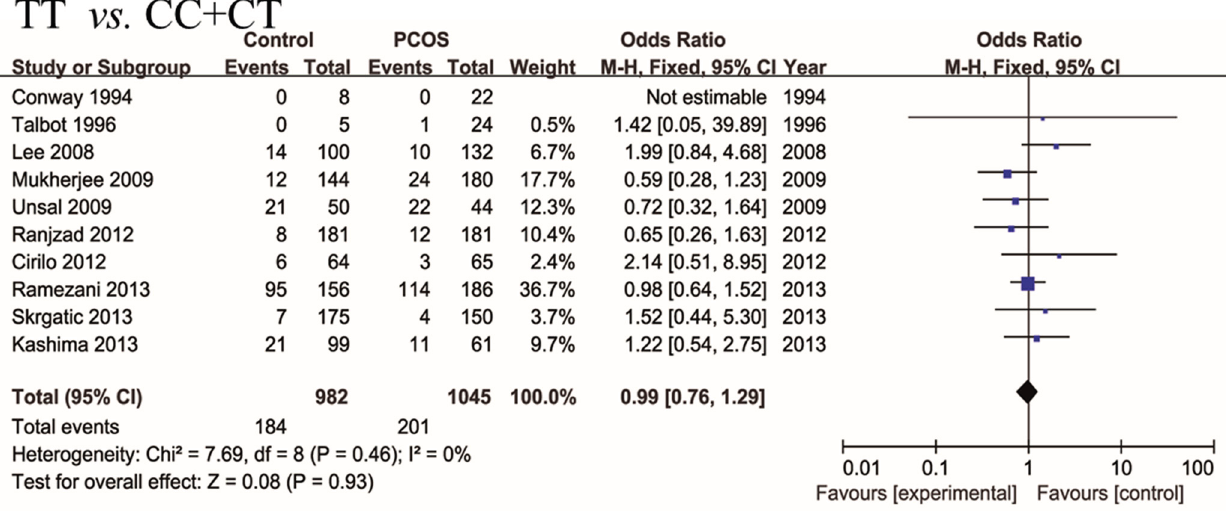
Figure 3. Forest plots of meta-analyses on association between rs1799817 frequency and PCOS